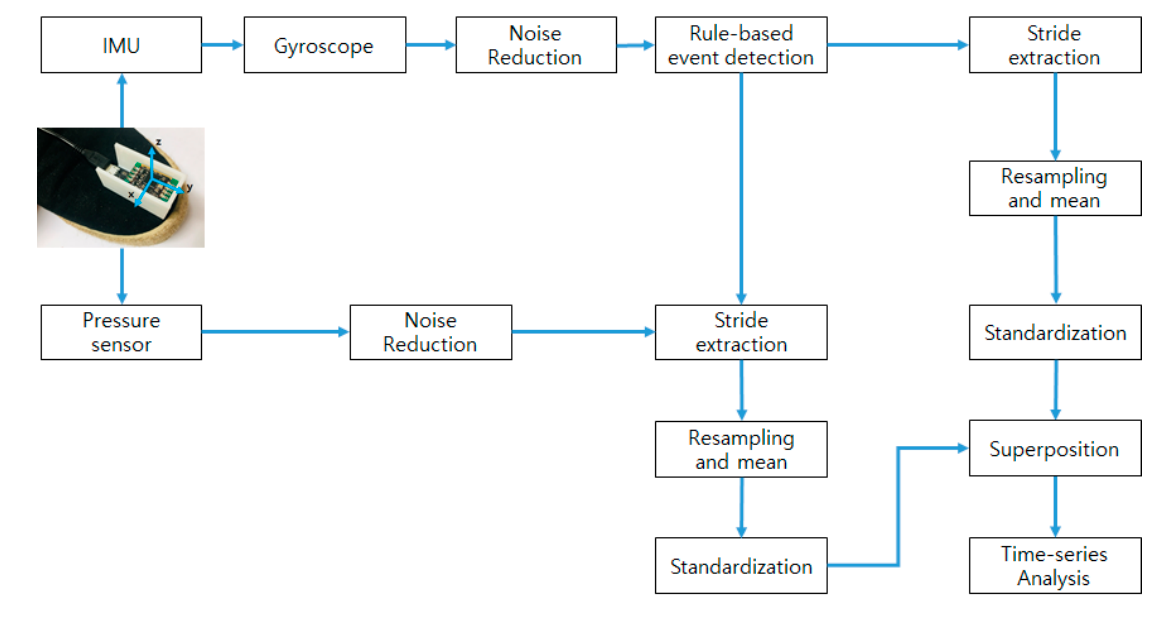
Figure 6. Flow chart for signal processing.